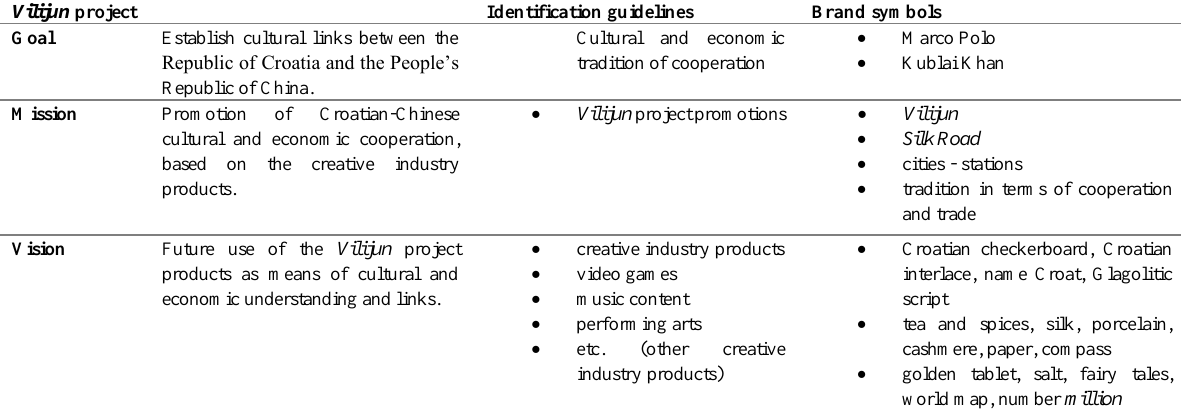
Table 1: Goal, mission and vision of the Vilijun project